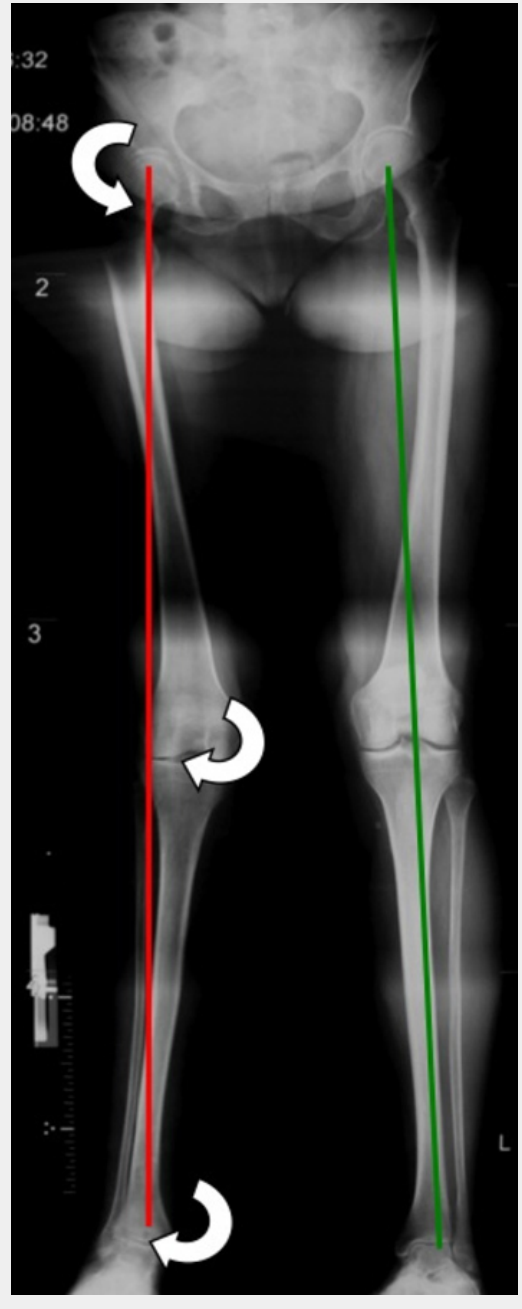
Long leg film with right side genu valgum and advanced ankle arthritis. The white arrows indicate the abduction moments on each joint resulting from the deviated mechanical